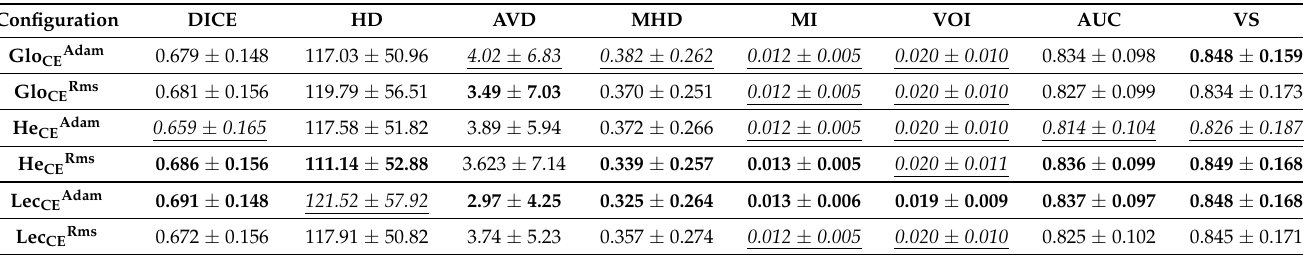
Figure 7. Segmentation results of Liver in axial, coronal, sagittal and 3D view using Glo tanh with best Dice score viewed in ITK-Snap Viewer [51]. Table 3. Mean and standard deviation values for Segmentation metrics on Pancreas Database (higher values represented in bold and lower values in italics with